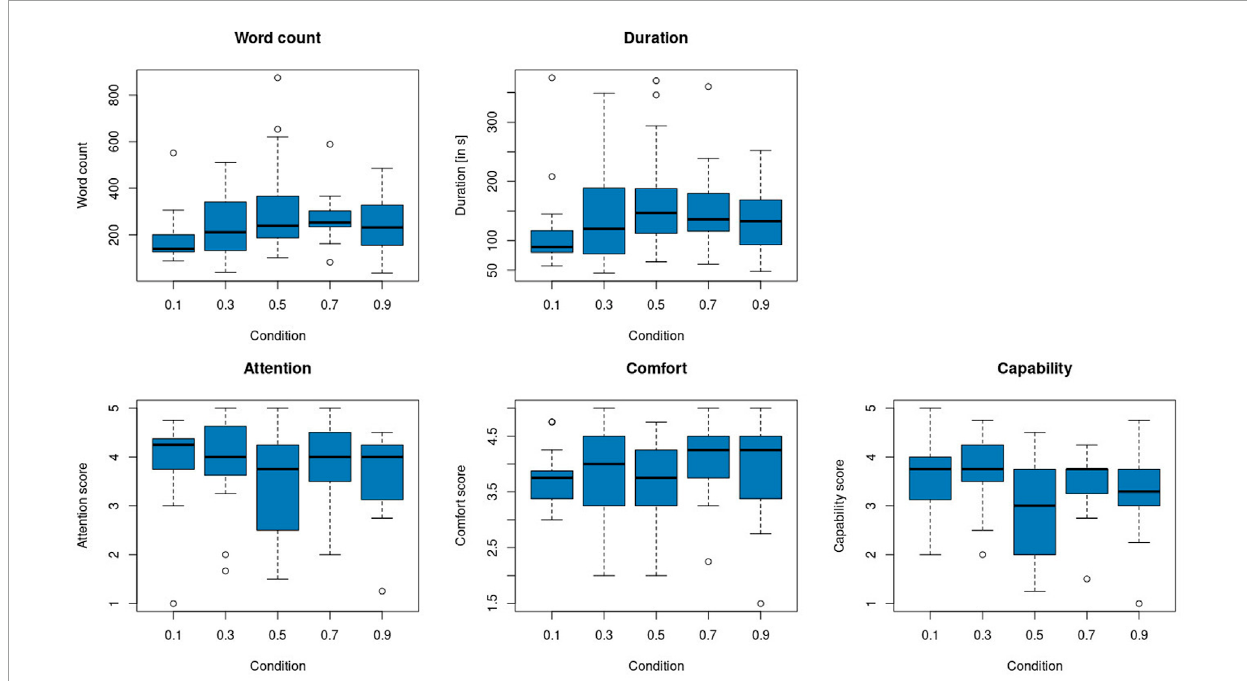
FIGURE 9 Top: word count (left) and duration (right) per GAR condition. Bottom: attention displayed by the robot (left), comfort during the interaction (middle), and perceived robot capability (right) per GAR condition.